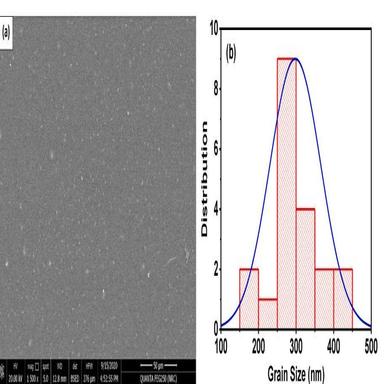
(a) SEM image, and (b) Size distribution histogram of PVA structure.